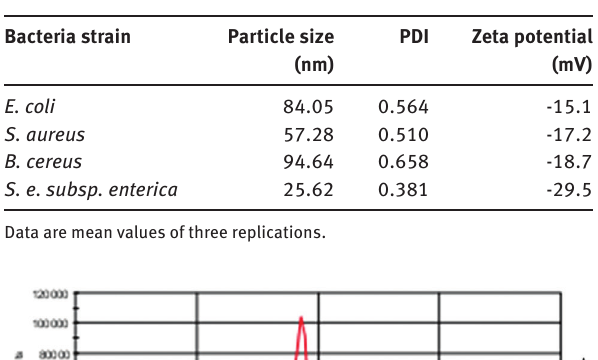
Table 3: Physico-chemical characteristics of the fabricated Ag NPs using bacterial extracts.